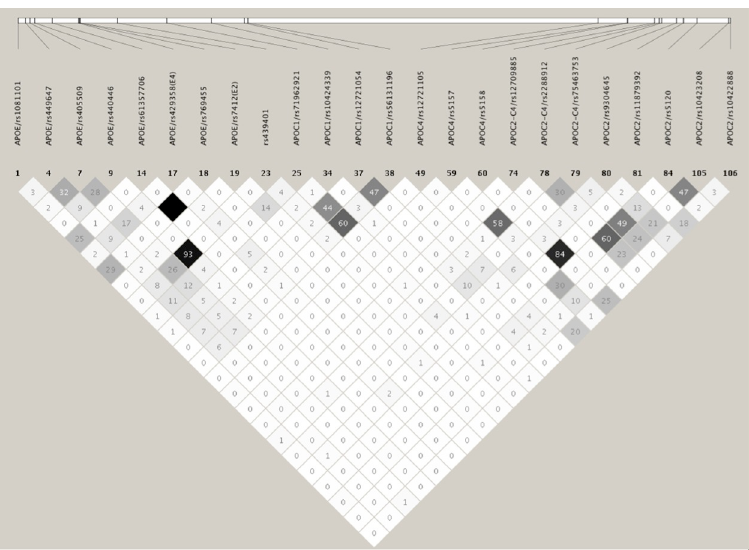
Fig 2. LD plot of the 24 common/uncommon variants (MAF > 1%) showing suggestive evidence of association with lipid traits in African blacks. The values in the cells are the pairwise degree of LD indicated by r 2 × 100. r 2 = 0 is shown as white, 0 < r 2 < 1 is shown in gray and r 2 = 1 is shown in